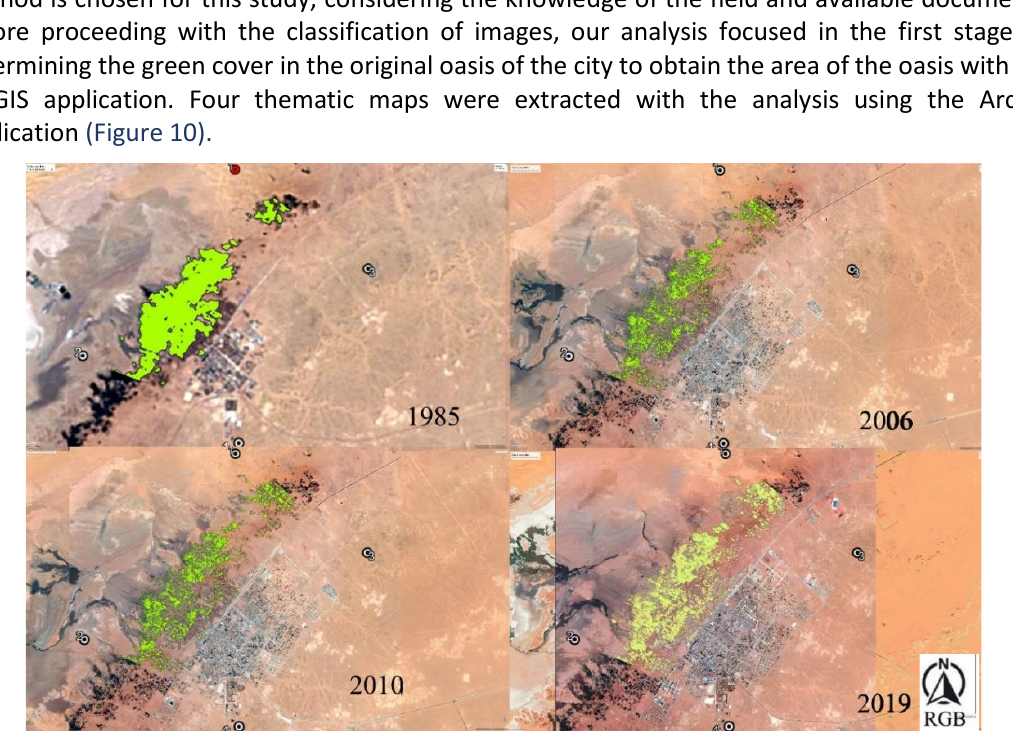
Figure 10 Classification and decreased change of green patches (Palm Groves) in Timimoun by